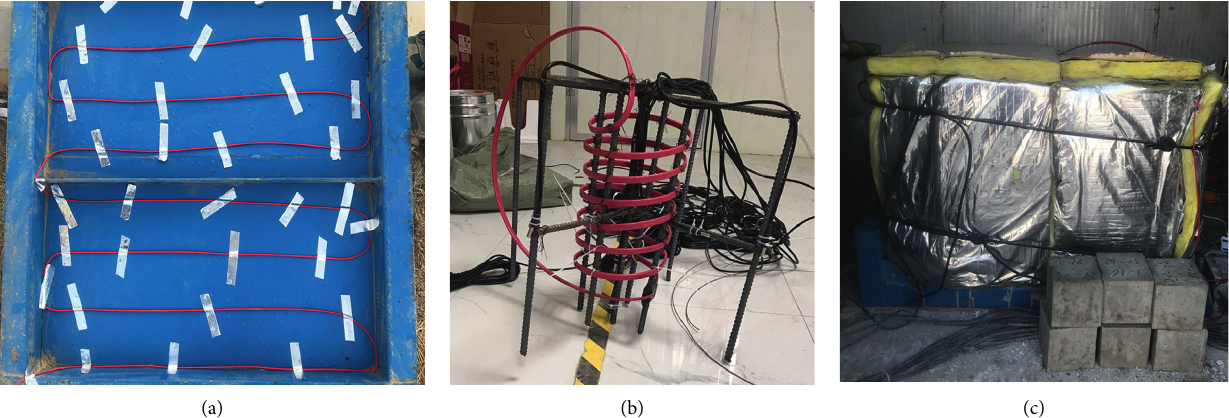
Figure 2: Photos of thermal control measures. (a) Heated steel formwork. (b) Electric heating band. (c) Test specimen wrapped in rock wool insulation.